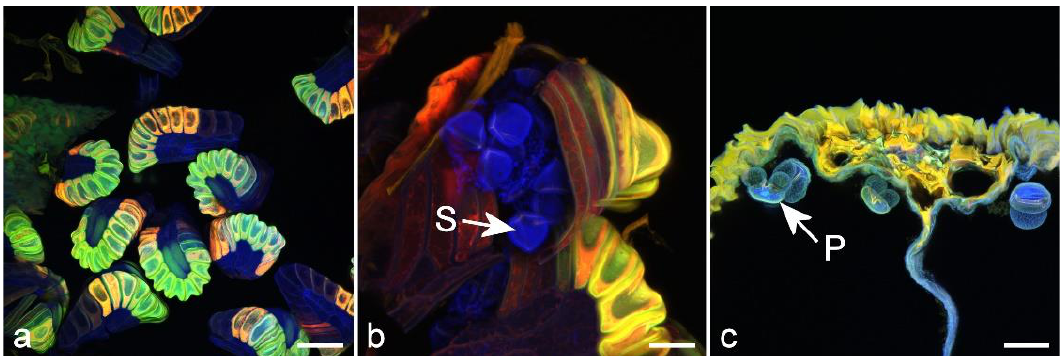
Figure 7. Autofluorescence in reproductive structures. ( a ) Immature fern sporangia. Scale bar = 100 ( b ) Mature sporangium with spores (S). Scale bar = 33 µ m. ( c ) TS of a male cone in pine with mature µm. ( b ) Mature sporangium with spores (S). Scale bar = 33 µm. ( c ) TS of a male cone in pine with pollen grains (P). Scale bar = 50 µ mature pollen grains (P). Scale bar = 50 µm.